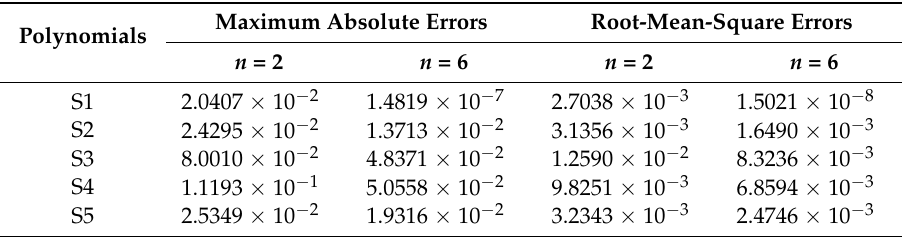
Table 2. Result comparison of Example 2 for different orthogonal polynomials at different values of n